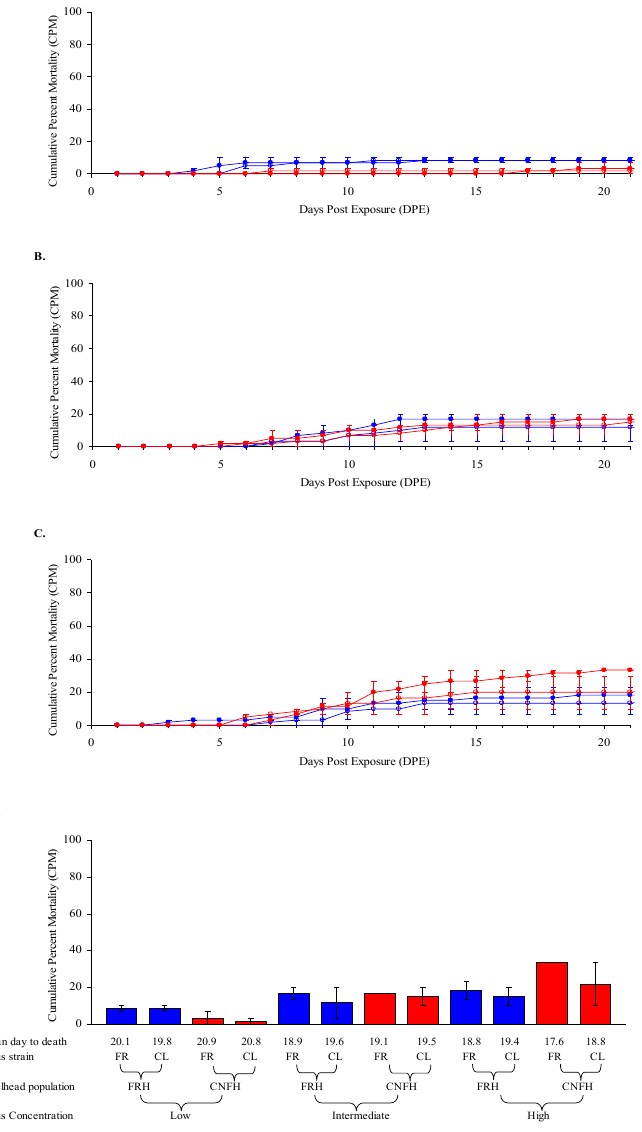
Figure 3. Mortality of steelhead fry exposed to IHNV at 12 °C. Average daily cumulative percent mortality (CPM) for duplicate groups of 30 Feather River Hatchery (FRH) (blue) and Coleman Na- tional Fish Hatchery (CNFH) steelhead (red) fry after waterborne exposure to ( A ) low, ( B ) interme- diate and ( C ) high doses of infectious hematopoietic necrosis virus subgroup LII isolates FR04 (filled symbols) and CL02 (open symbols) at a water temperature of 12 °C. Actual exposure doses deter- mined on the day of challenge were: FRH, 1.2 × 10 4 , 1.2 × 10 5 , and 1.2 × 10 6 pfu mL − 1 ; and CNFH, 2.0 × 10 4 , 2.0 × 10 5 , and 2.0 × 10 6 pfu mL − 1 . ( D ) Bars show average CPM (±SE) in duplicate treatment groups. Absence of SE bars indicates that duplicate groups had identical CPMs.